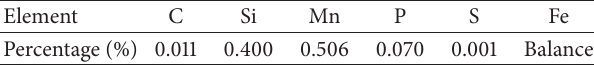
Table 1: Chemical composition of silicon steel, wt%. Element C Si Mn P S Fe Percentage (%) 0.011 0.400 0.506 0.070 0.001 Balance